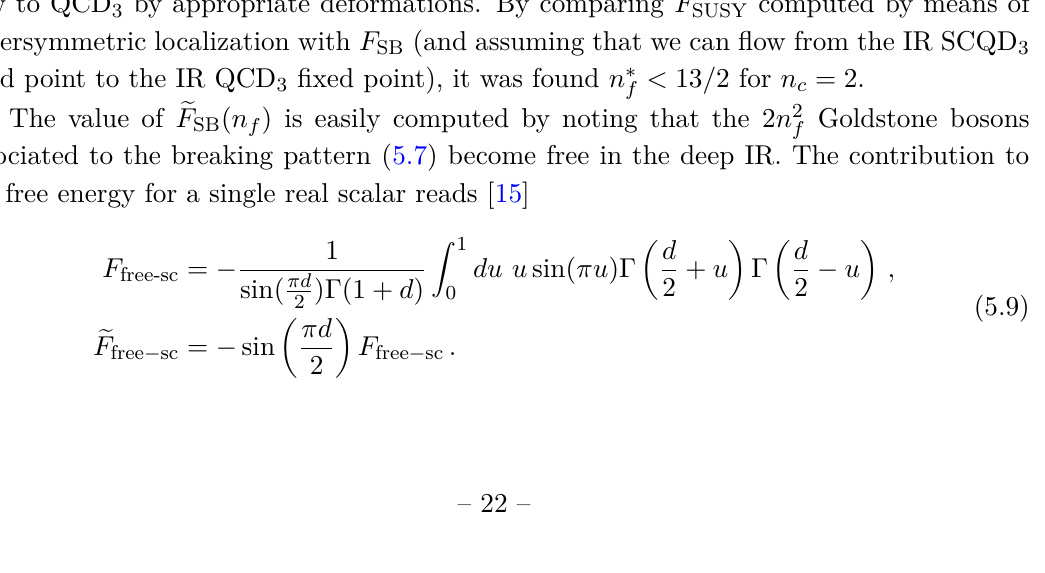
= 2 , 3 , 4 , 5 . The value of n c f